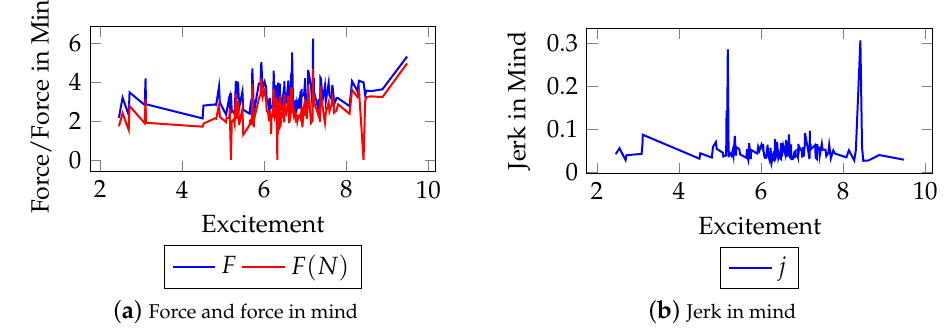
Figure 4. Bridging ride and play comfort via measure of ( a ) forces and ( b ) jerk in